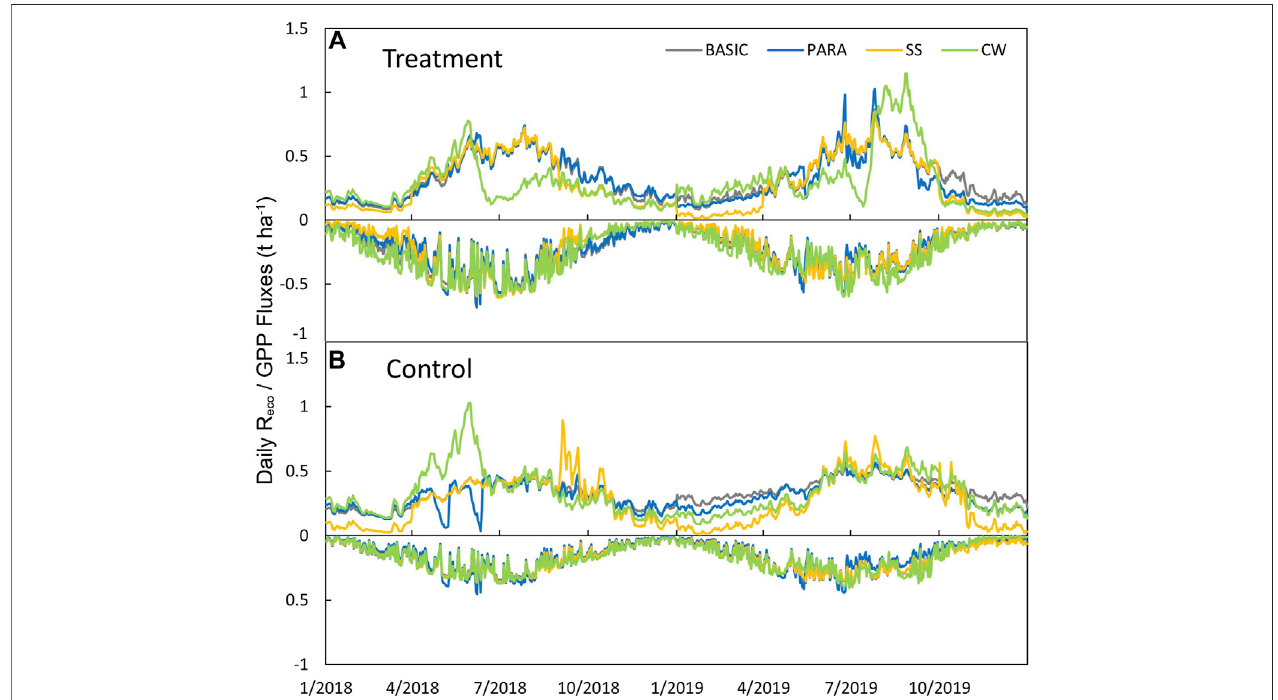
FIGURE4| Gap- fi lleddailysummedCO 2 fl uxes(R eco andGPParedepictedasthepositiveandnegativevalues,respectively)fromdifferentmodelsat (A) treatment and (B) control site of the demonstration location 5.